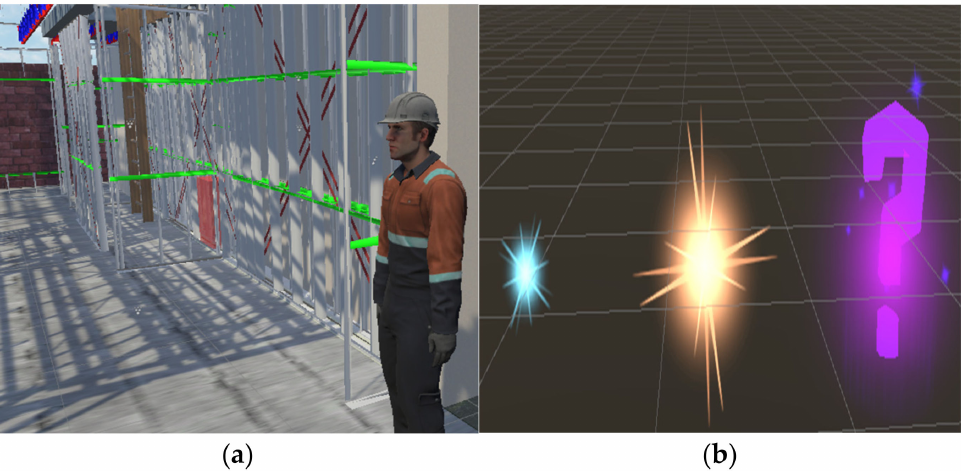
Figure 3. Audio-visual-based training scenario. ( a ) Virtual instructor and LSF system; ( b ) Examples of visual effects